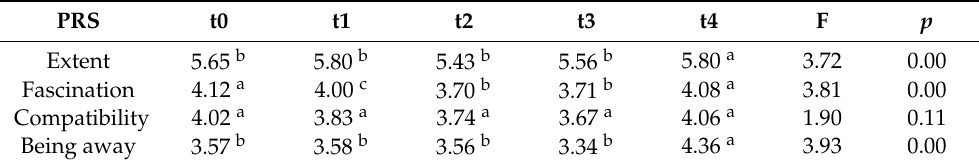
Table 6. ANOVA results across the four dimensions compared to different lengths of time.